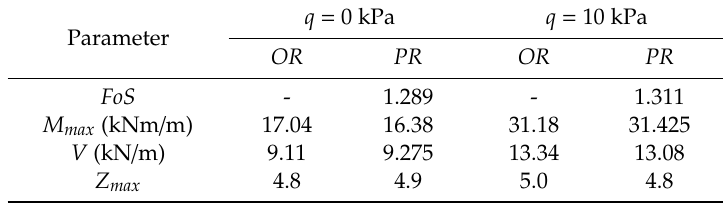
Table 6. Comparison of optimization results and numerical analysis for 4 m excavation depth.